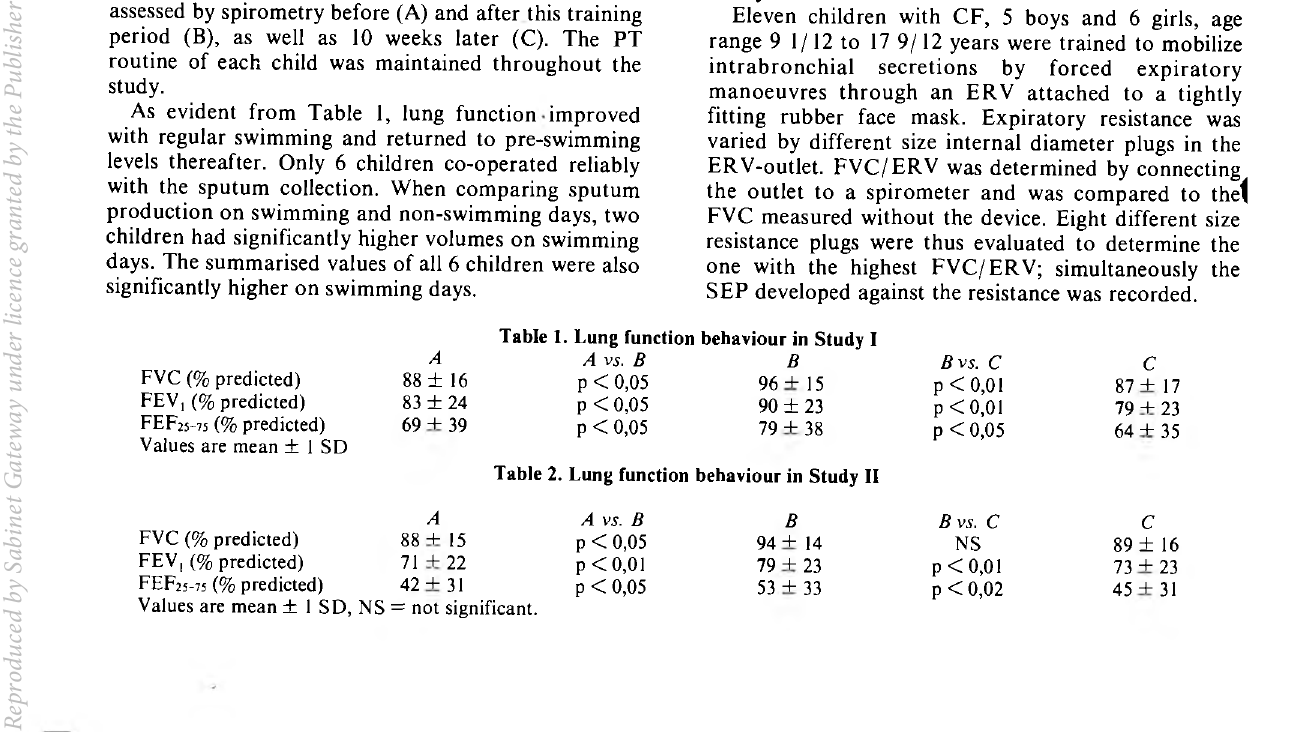
Table 1. Lung function behaviour in Study I A vs. B